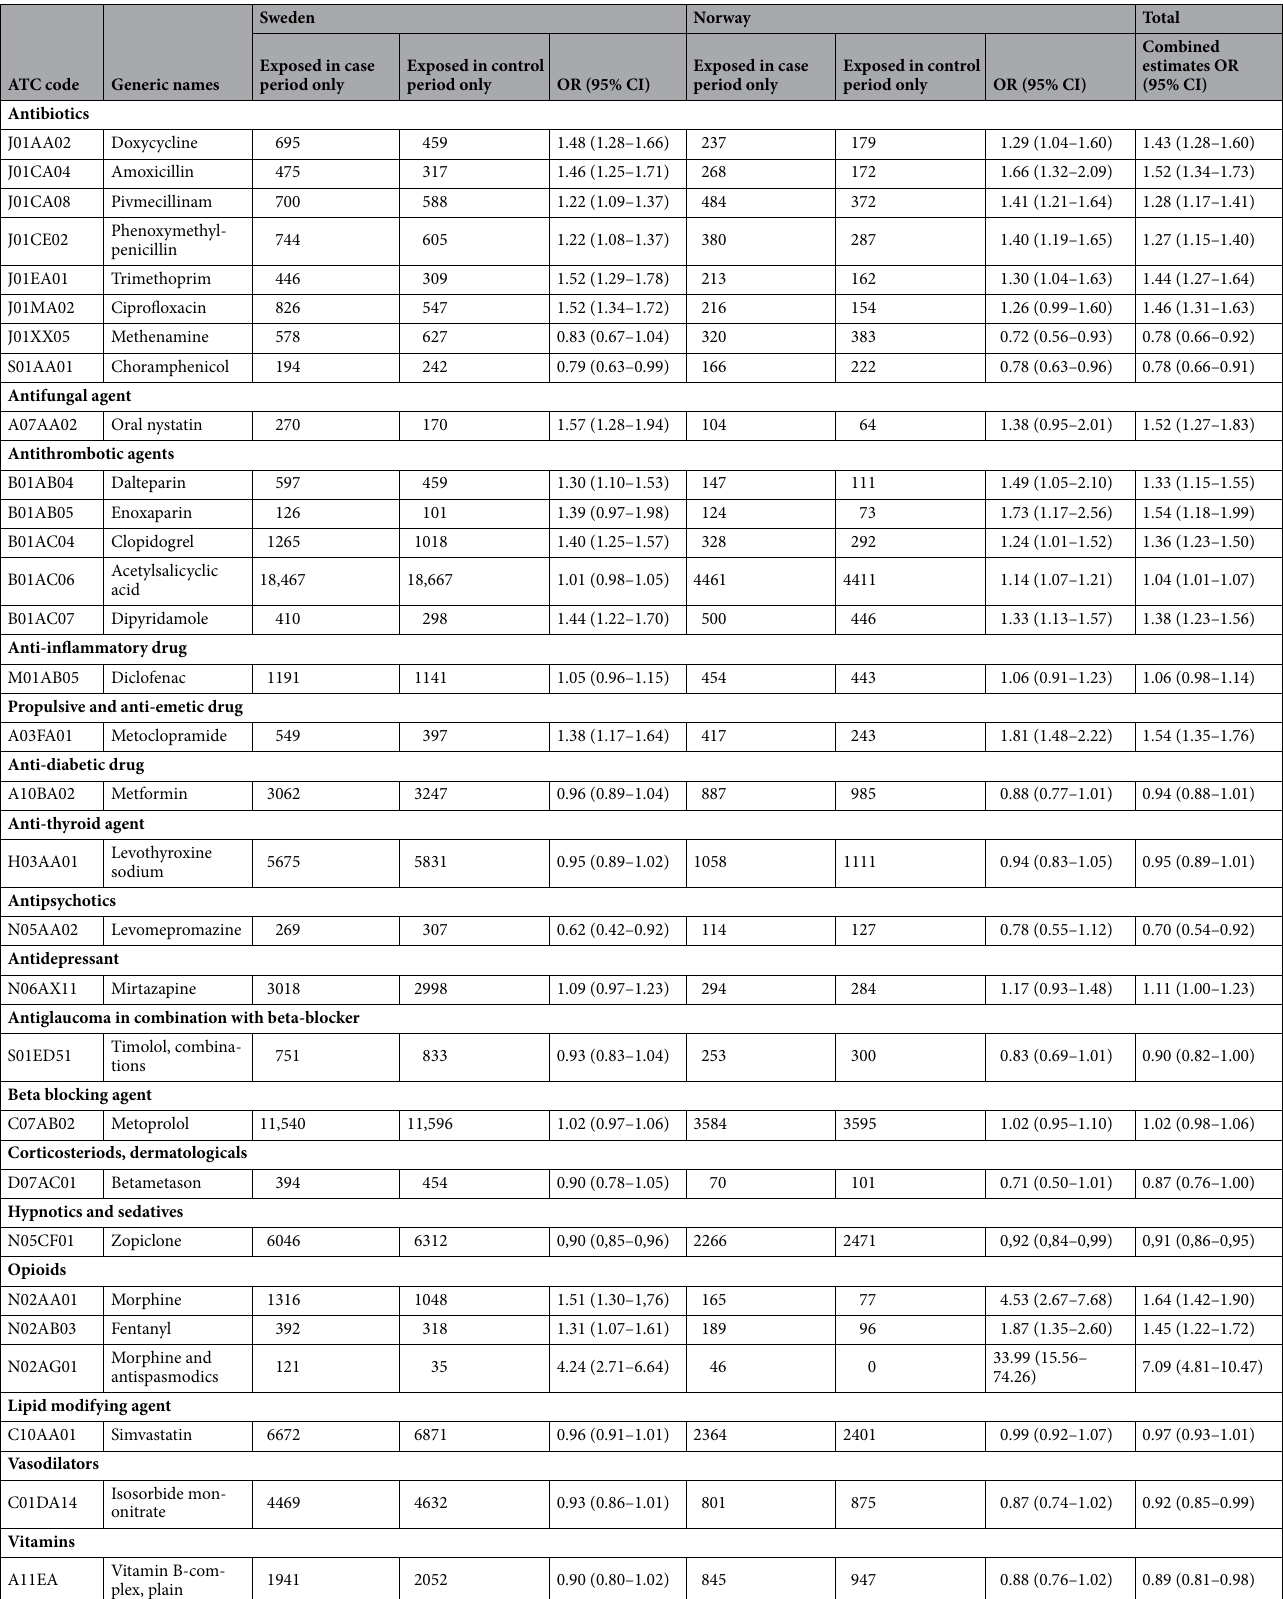
Table 2. Odds ratios for ischemic stroke within 14 days following the drug was dispensed, selected by BOLASSO approach in both countries. All generic names listed according to the Anatomical